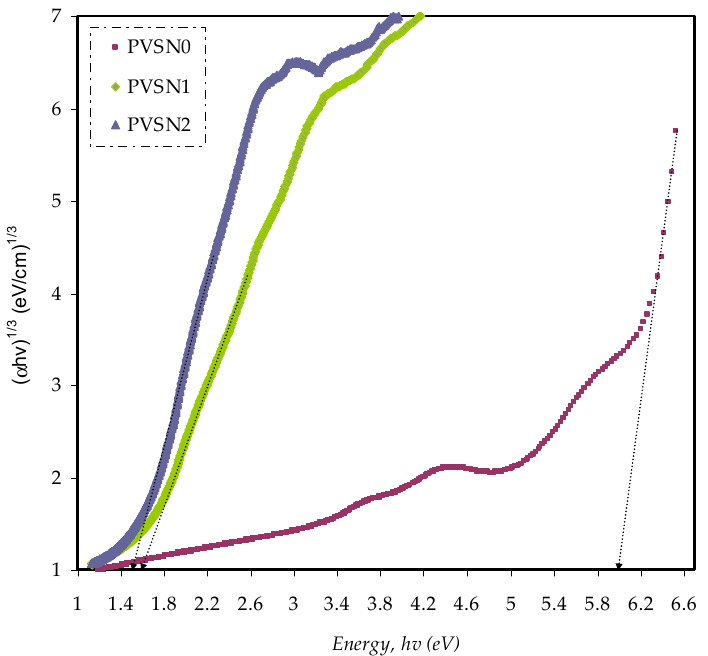
Figure 14. Plot of ( α h υ ) 1/2 vs. h υ for pure PVA and PC films.